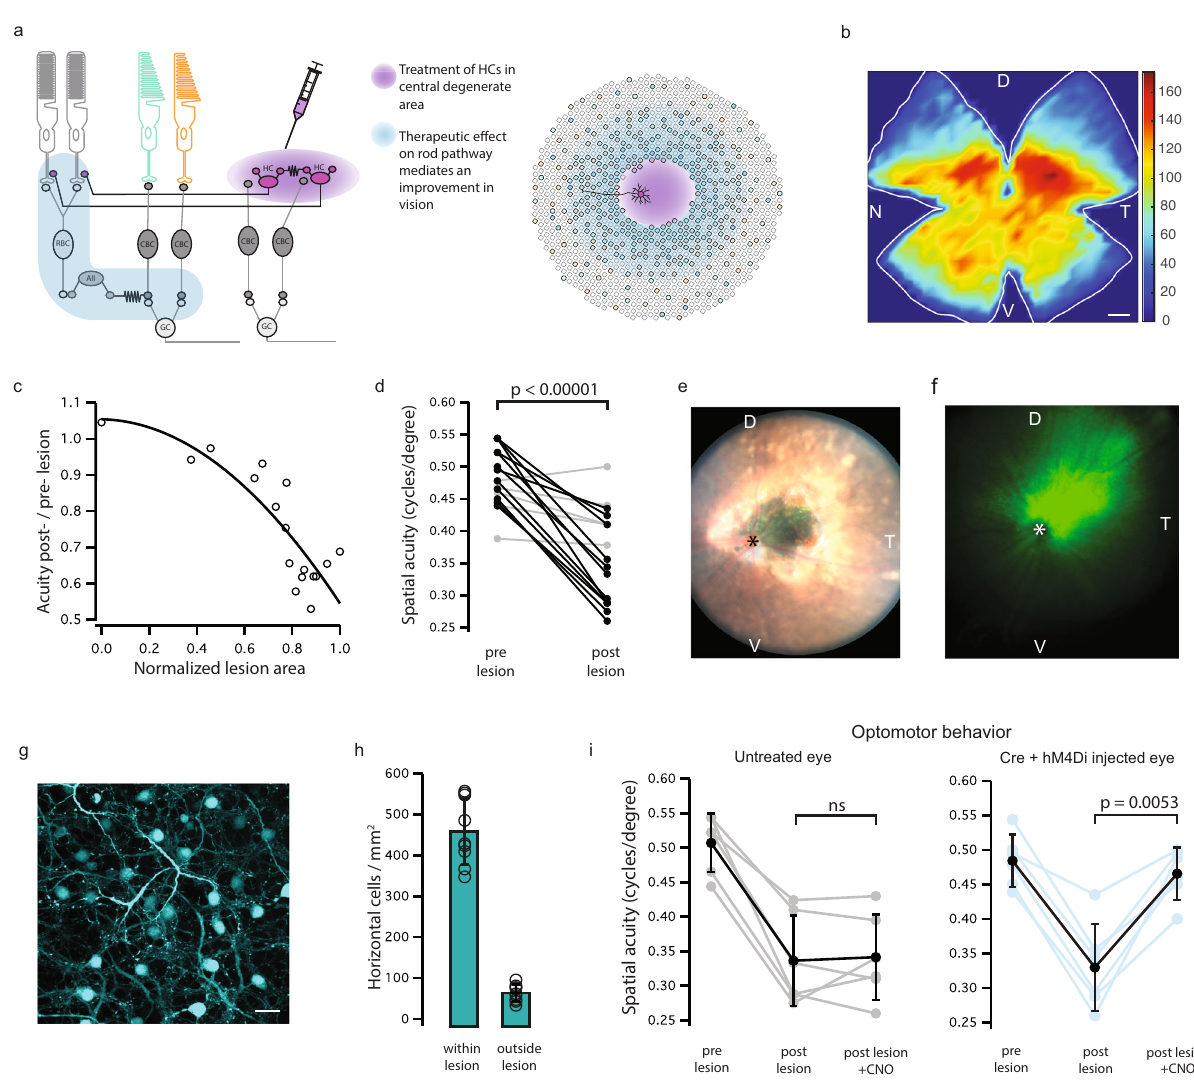
Fig. 5 Improved vision following the restoration of lateral input to rod photoreceptors in a mouse model of focal photoreceptor loss. a Schematic showing the therapeutic strategy to improve remaining vision following the loss of lateral feedback. H1 horizontal cells provide feedback to laterally displaced rods, modulating their output onto cone pathways (left panel). Following focal photoreceptor degeneration, lateral input to surviving photoreceptors can be restored by transduction of horizontal cells with a hyperpolarizing actuator. b Ganglion cell density in WT mouse retina (Brn3a immunohistochemistry); color scale indicates RGC density/bin (bin: 0.1 mm 2 ). D dorsal, V ventral, T temporal, N nasal. Scale bar: 800 μ m. c Lesions in the dorso-ventral quadrant of the retina reduced the acuity threshold of WT mice. Plot shows acuity drop versus lesion size for individual eyes ( fi tted curve r 2 = 0.73, n = 17 eyes). d Reduction in acuity following lesion for all eyes tested ( n = 17 eyes; p < 0.00001; two-sided paired t -test,). Gray indicates lesioned area <30th percentile; ( n = 5 eyes), black >30th percentile ( n = 12 eyes). e Example fundoscopy image of WT mouse retina, showing a lesion in the dorsal- temporal quadrant and hM4Di-GFP-transduced cells. Asterisk indicates the location of the optic nerve, orientation indicated by D dorsal, V ventral, T temporal. f Injection of hM4Di construct targeted to the lesion. Average hM4Di-GFP-expression in retinal fundus images ( n = 15 eyes) showing strong expression in the dorso-temporal quadrant. Asterisk indicates the location of the optic nerve, the orientation of the retinal image is indicated by the letters D dorsal, V ventral, T temporal. g Whole-mount confocal image of lesioned and transduced WT mouse retina showing dense labeling of horizontal cells in a region depleted of photoreceptors (scale bar; 20 μ m). h Density of viral transduction was higher within the lesioned area than outside the lesion border ( n = 9 eyes). i Following lesion of the dorsal-temporal retina, CNO administration signi fi cantly improved spatial acuity in h4MDi injected eyes only (right panel, n = 6 eyes from six mice; p = 0.0053, one-way repeated measures ANOVA with Tukey post hoc multiple comparison test). See Supplementary Table 1 for all calculated p values. Error bars denote standard deviations around mean values. Source data are provided as a Source Data fi